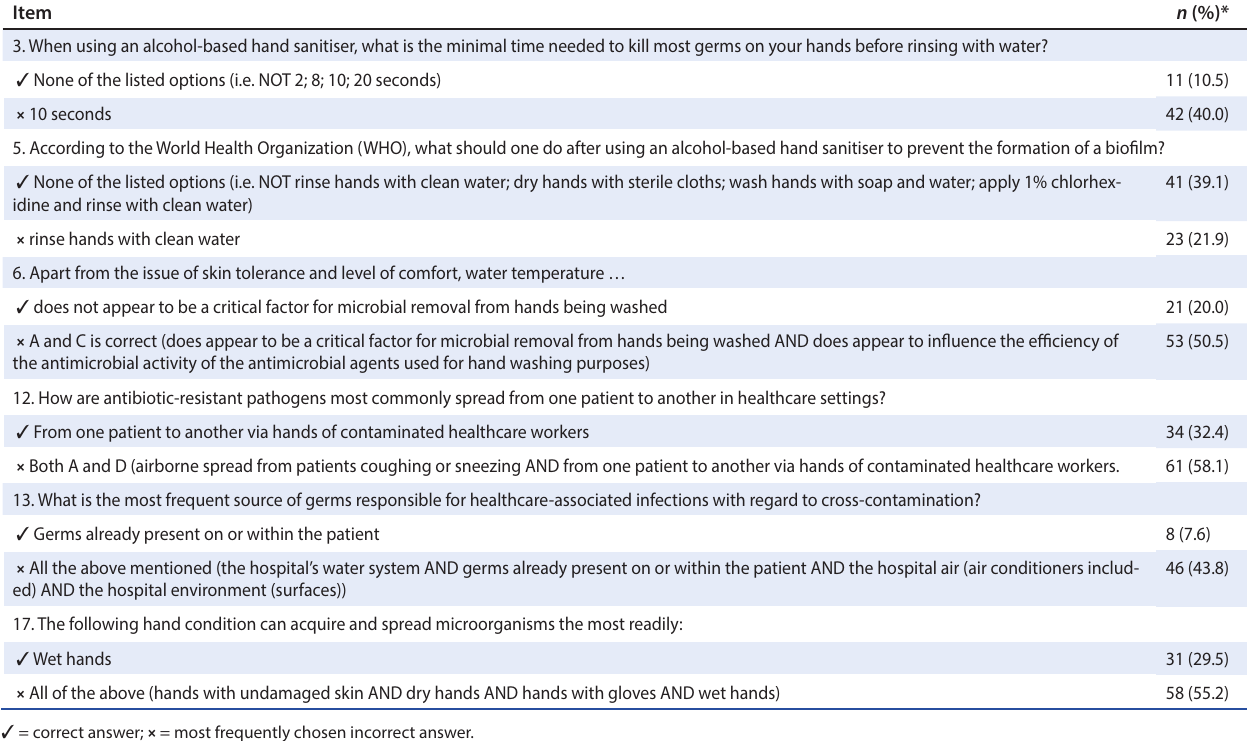
Table 2: Correct and most frequently chosen incorrect answer to questions where less than 40% of the students chose the correct option